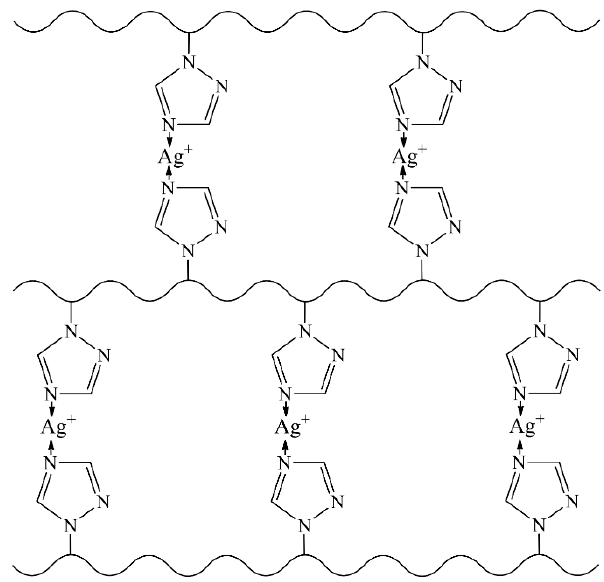
Figure 2. Schematic coordination interaction of silver ions with PVT macromolecules.